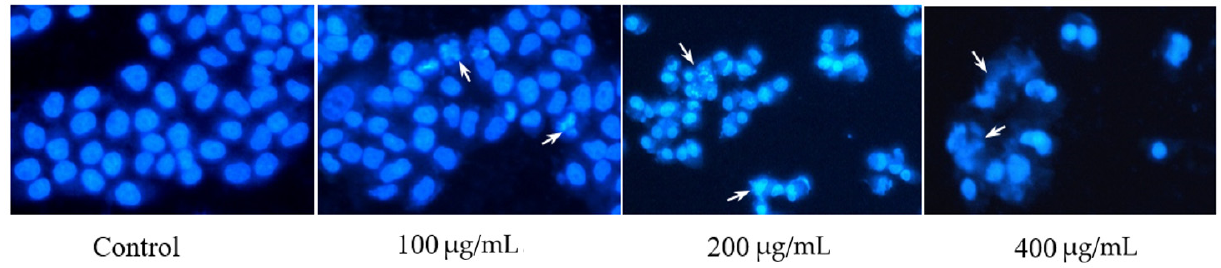
Figure 5. RLE-induced morphological changes on HT-29 cells after 24 h of exposure, analyzed in fluorescence microscope images.